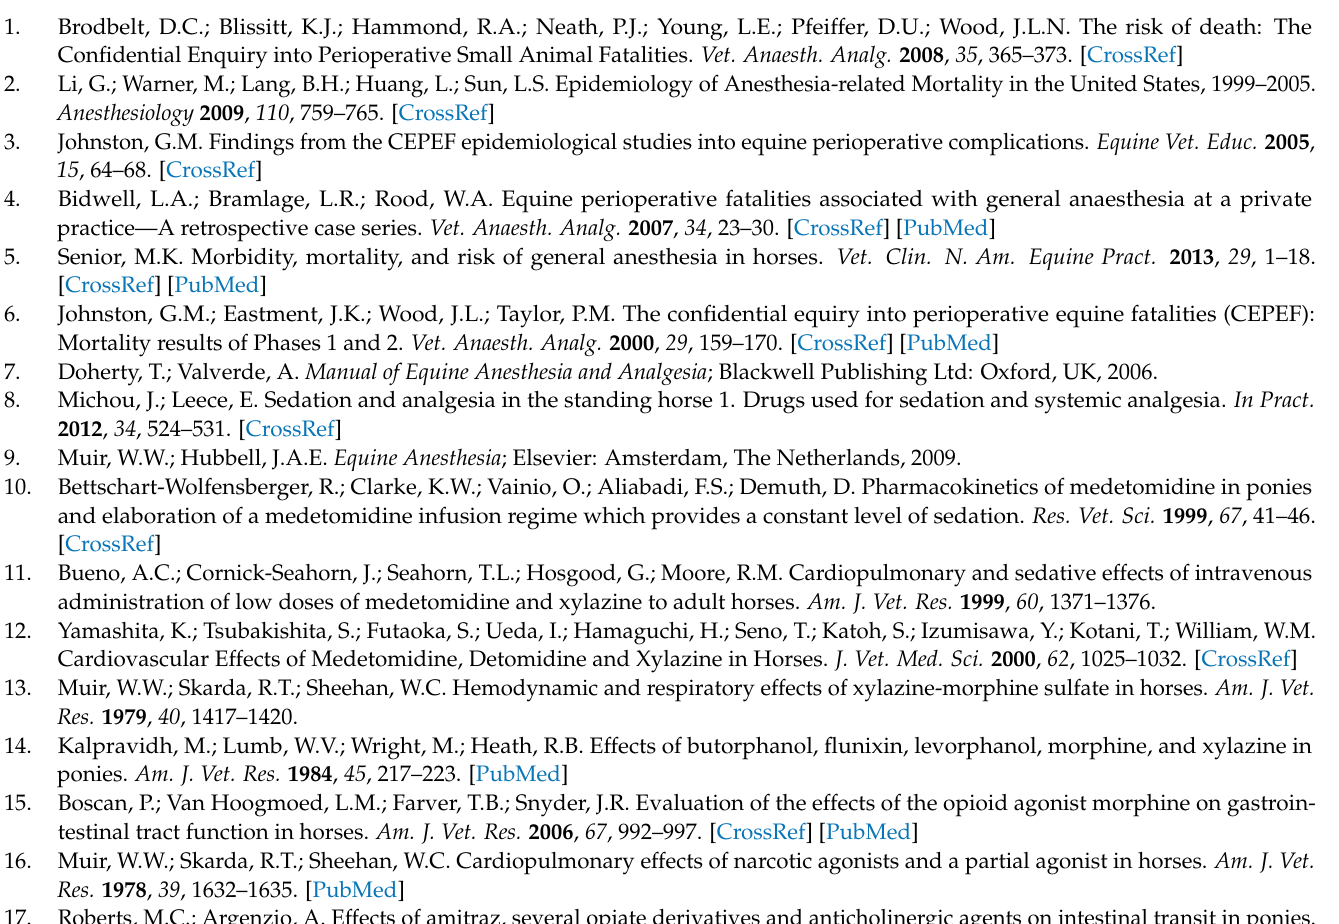
pulmonary artery. Table S2. Electrocardiographic intervals duration. Table S3. Partial gas arterial pressures, electrolytes and acid-base parameters. Table S4. Percentage of head height to ground with baseline as reference (100%). Table S5. Visual Analogic Scale evaluation of ataxia (cm) between 0 (normal horse) to 10 (horse unable to